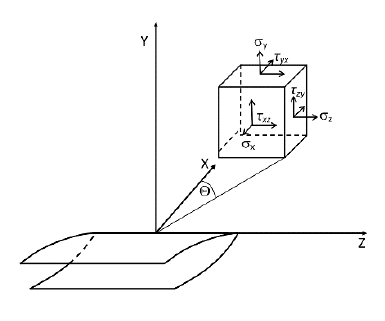
Fig. 5. Stress components and crack